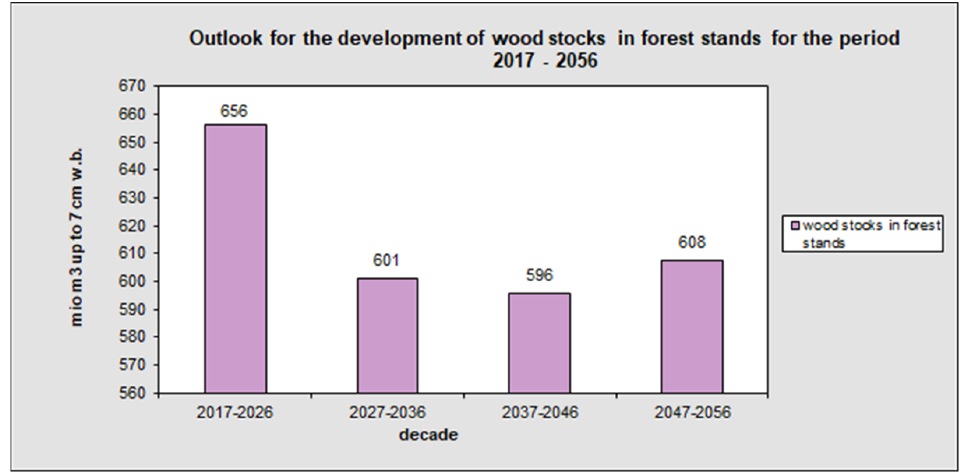
Figure 1. Outlook for the development of wood stocks in forest stands.